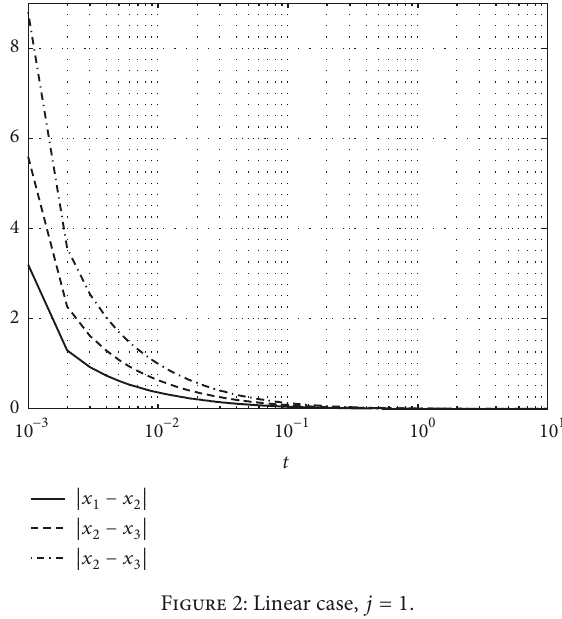
Figure 2: Linear case, 𝑗 = 1 .